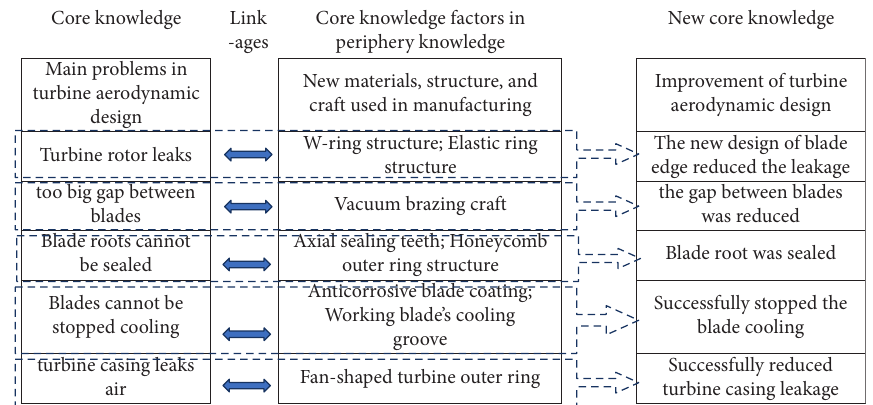
Figure 5: Knowledge innovation mechanism in R&D